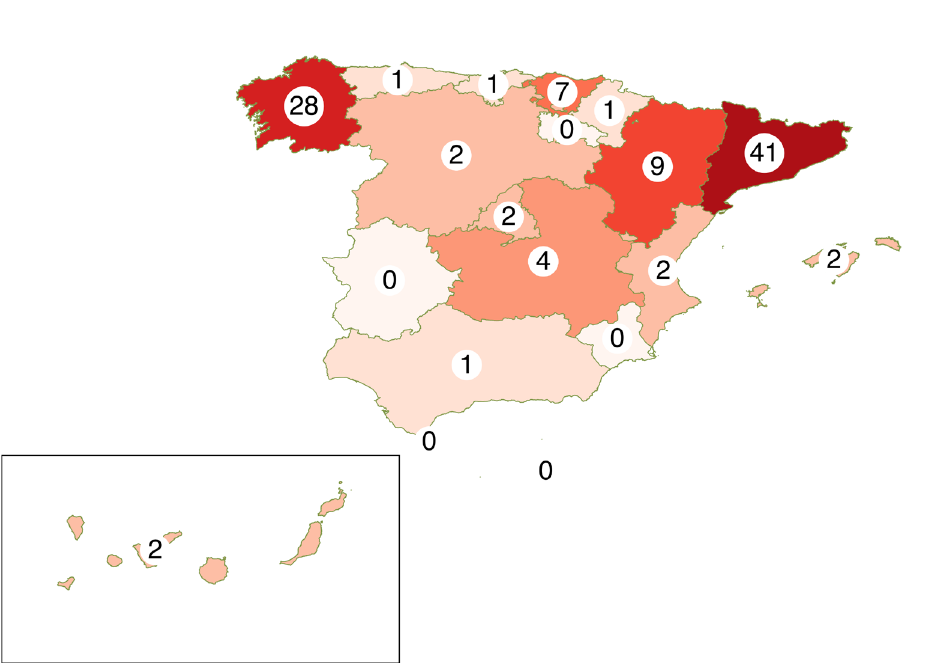
Figure 1. Number of bryophyte species currently present in national or regional catalogues with populations in the different regions (autonomous communities). Note that the figures show the sum of species present in each regional catalogue, plus the number of species nationally protected (present in LESRPE/CEEA) living in the